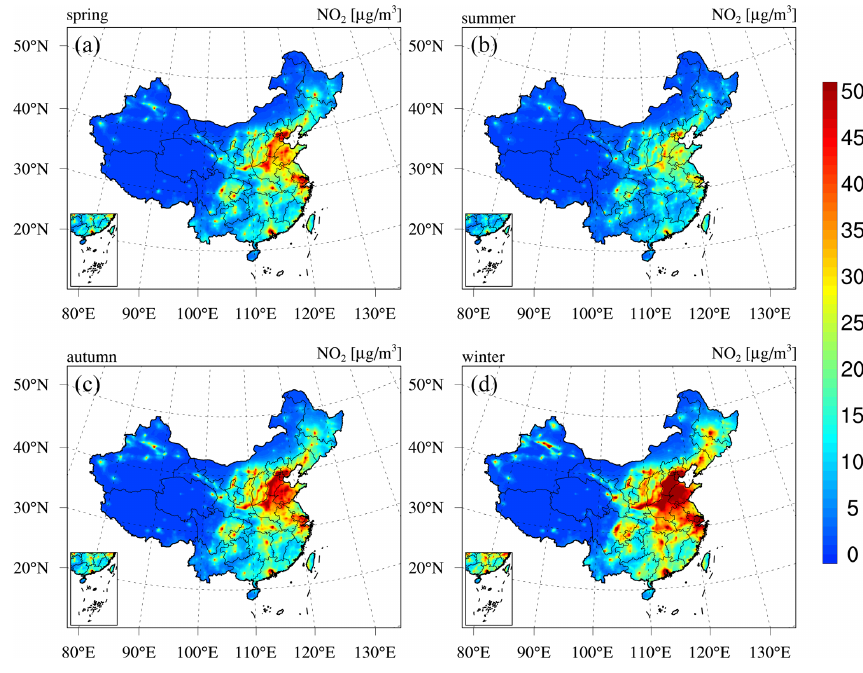
Figure D5. Same as Fig. D1 but for NO 2 .